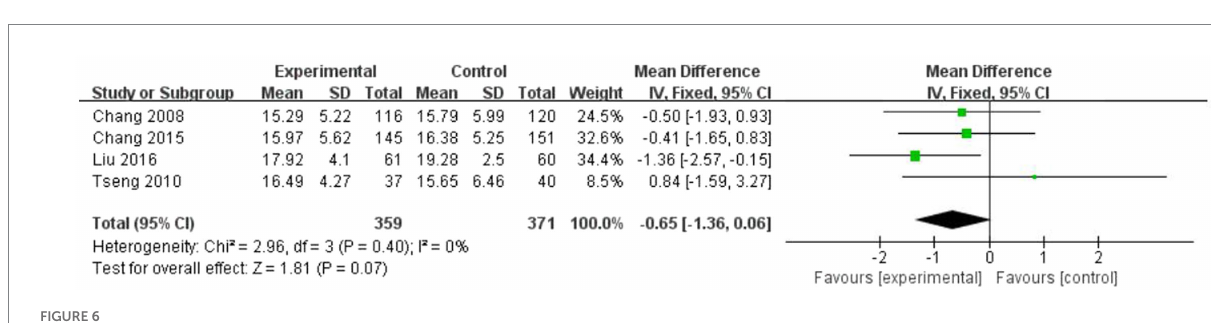
FIGURE 6 Forest plot of posttreatment stress outcome for comparing art-based intervention with